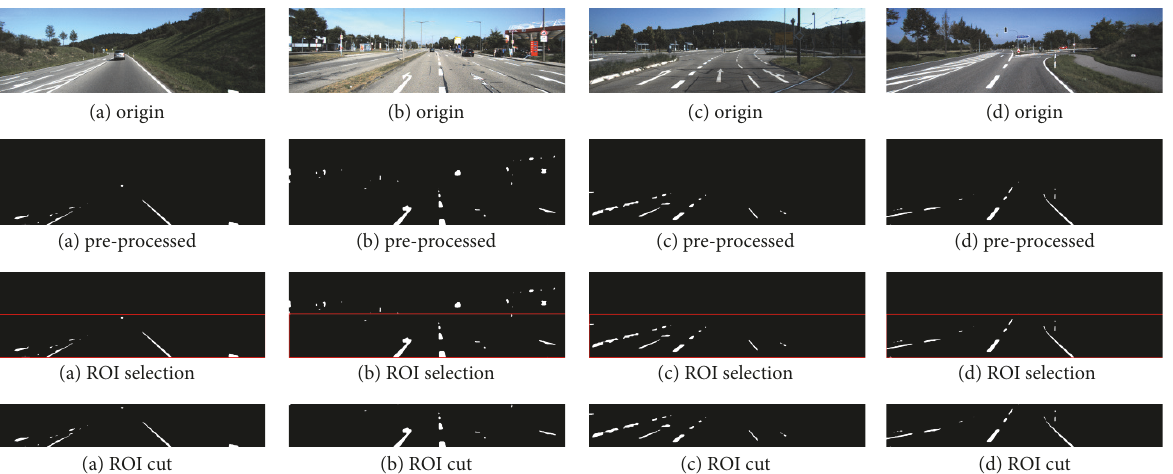
Figure 10: ROI selection of sample frames (a), (b), (c), and (d) based on the proposed